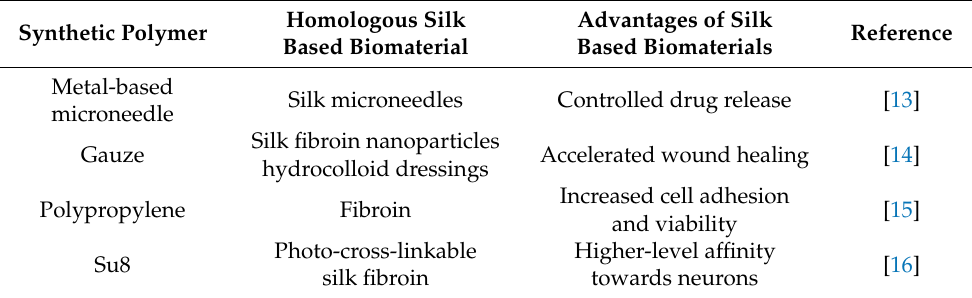
Table 1. The advantage of using silk-based biomaterial compared to synthetic polymers. Synthetic